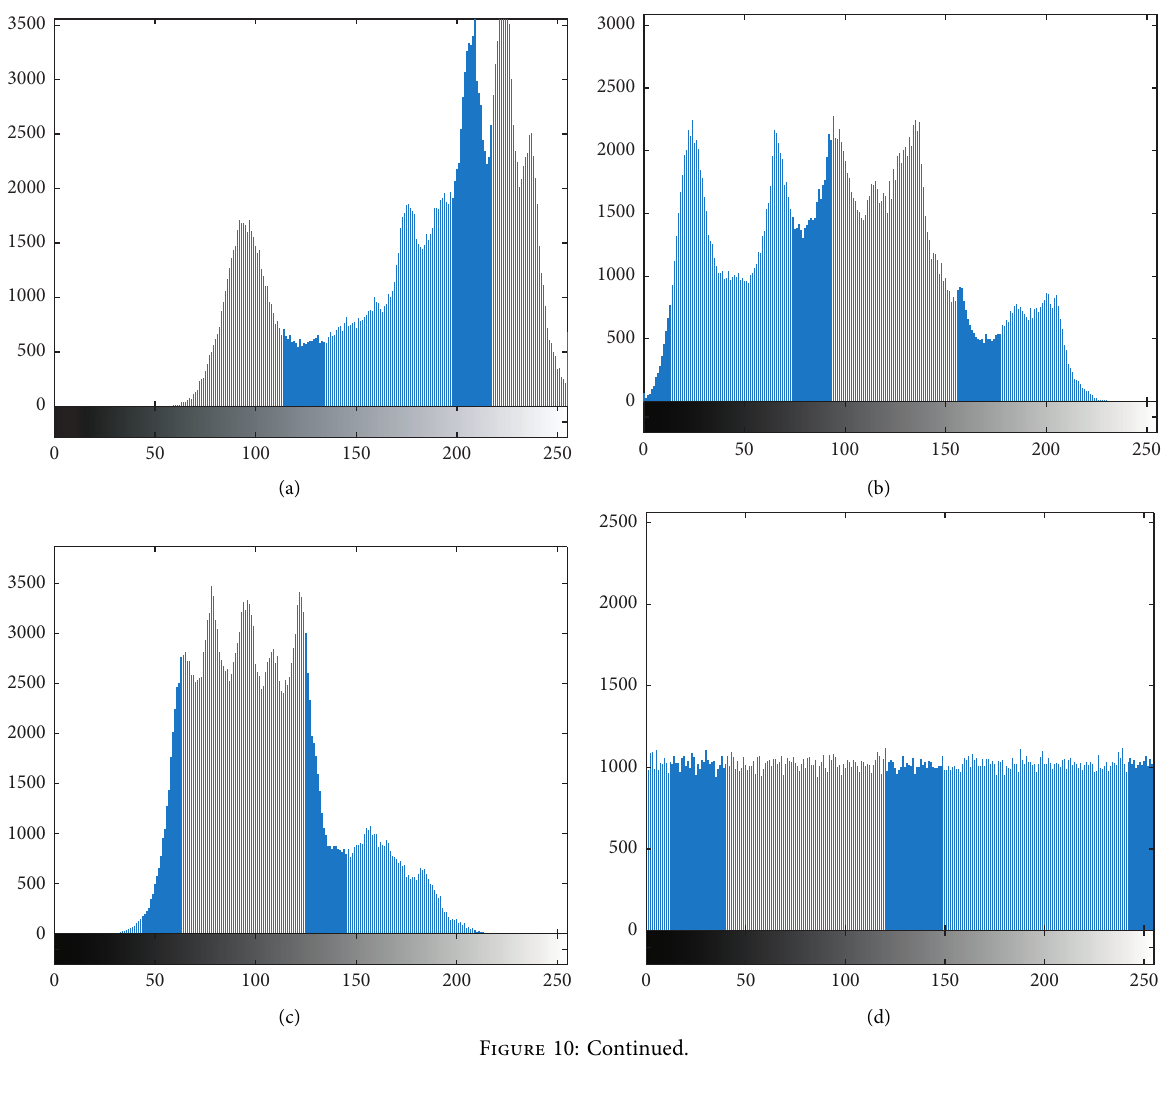
Figure 9: Decrypting Lena image by two secret keys K � x encrypted image with K ; (c) decrypted image with t K ; (d) decrypted image with the wrong key 􏽥 K